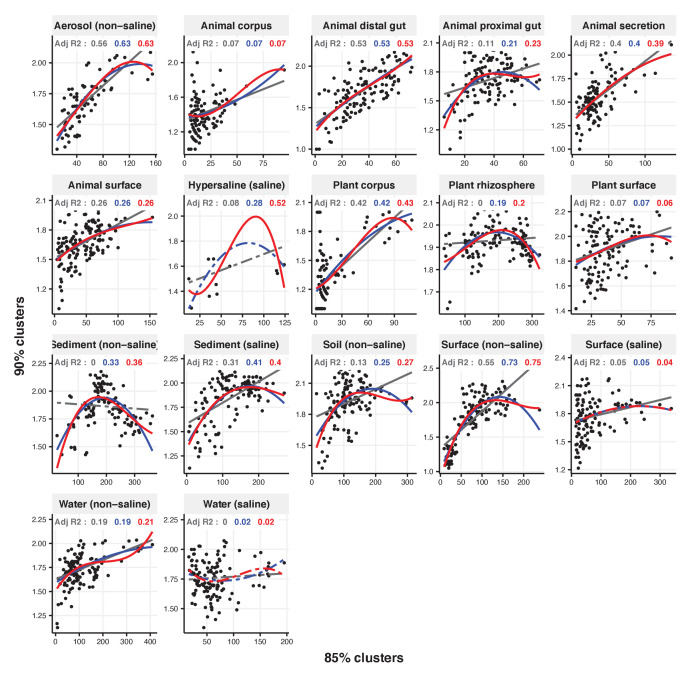
Focal clusters at 85% nucleotide identity.Community diversity was estimated as the number of clusters at a focal level (di) and focal lineage diversity as the mean of the clusters at the rank above (di 1/di). Linear (grey), quadratic (blue) and cubic (red), with corresponding adjusted R-squared values in the same colour. P-values are Bonferroni corrected for 17 tests. Significant, p<0.05 (solid lines), non-significant (dashed lines). The x-axis shows the number of clusters at the focal percent-identity level (di), and the y-axis is the mean of the clusters at the rank above (di 1/di).